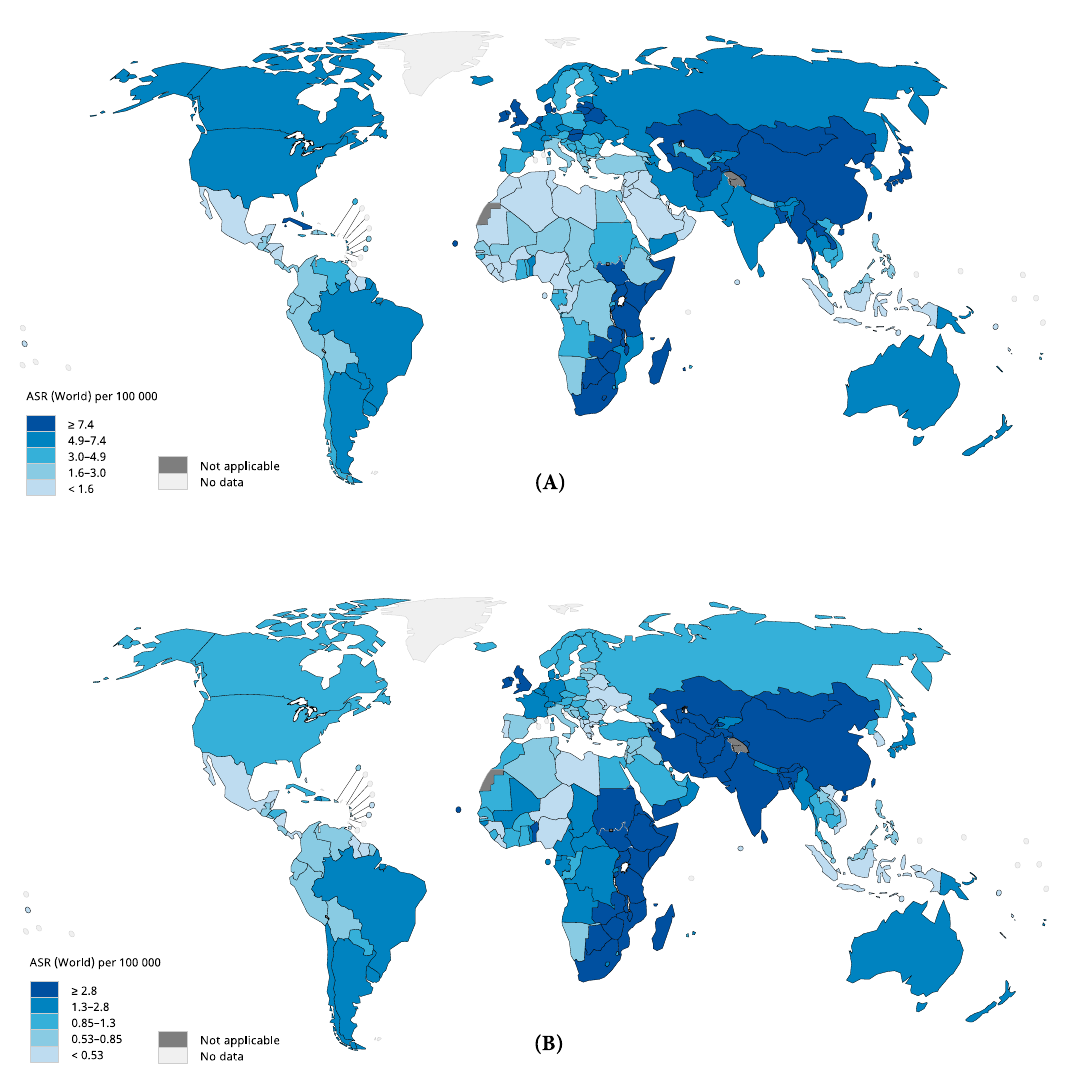
Figure 1. The global estimated incidence of esophageal cancer in 2018, both sexes, all ages: ( A ) male incidence; ( B ) female incidence. ASR, age-standardized rate. Data source: GLOBOCAN 2018, IARC (http://gco.iarc.fr/today), World Health Organization.